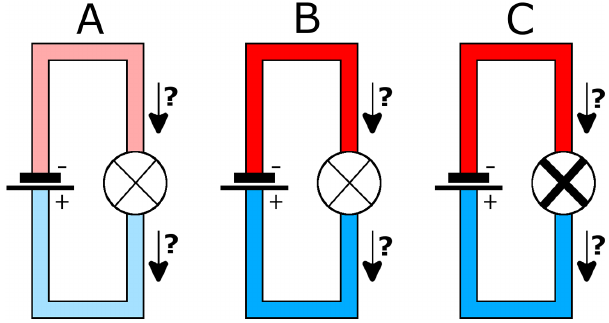
FIG. 9. Sample task to help students develop a qualitative understanding of how the electric current is dependent on electric pressure difference and resistance. The light bulb in circuit C has a higher resistance (illustrated by thicker lines). In this task, students are expected to identify that the flow of current is highest in circuit B, but might be the same in circuits A and C. The arrows only refer to the direction and not the magnitude of the electron flow.